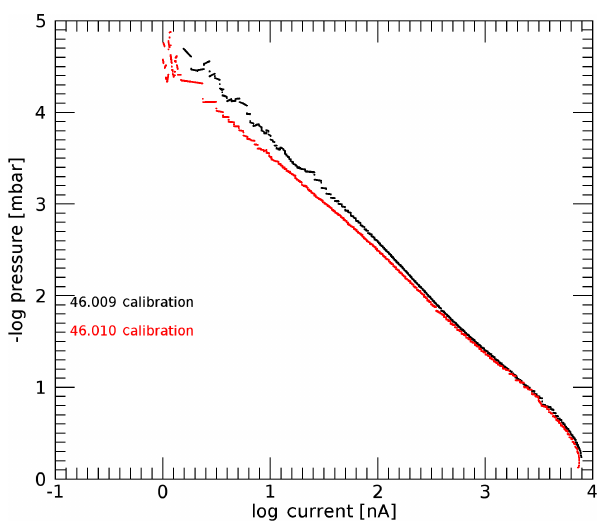
Figure 3. Ion currents observed during laboratory calibrations of the two CONE sensors. Irregularities at pressures below 10 − 3 mbar in one of the profiles are due to irregularities in the gas flow into the chamber and can be